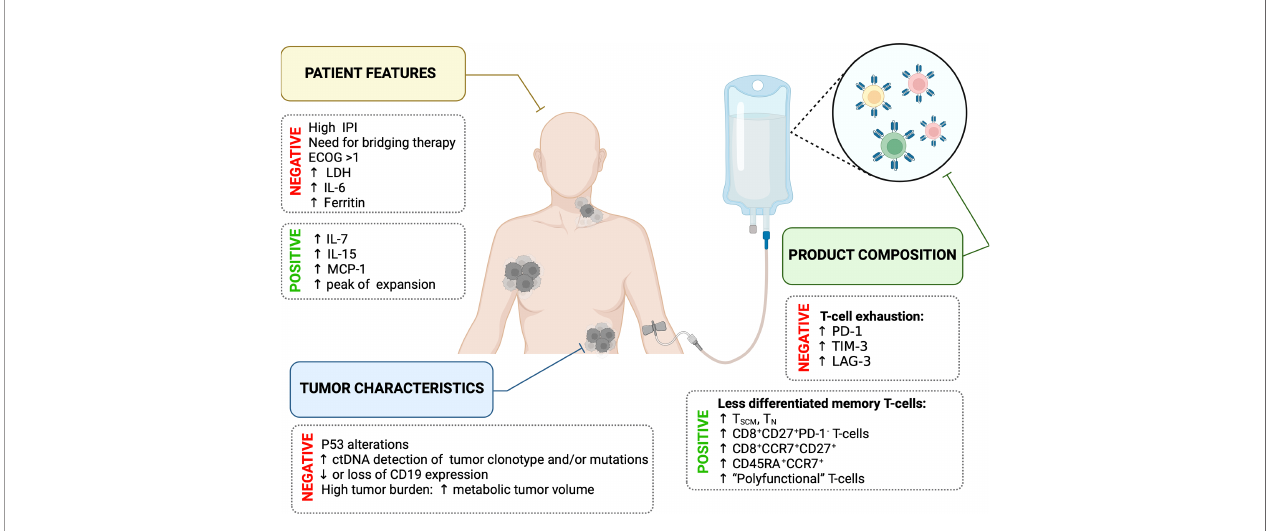
FIGURE 2 | Summary of main factors in fl uencing the ef fi cacy of CART19